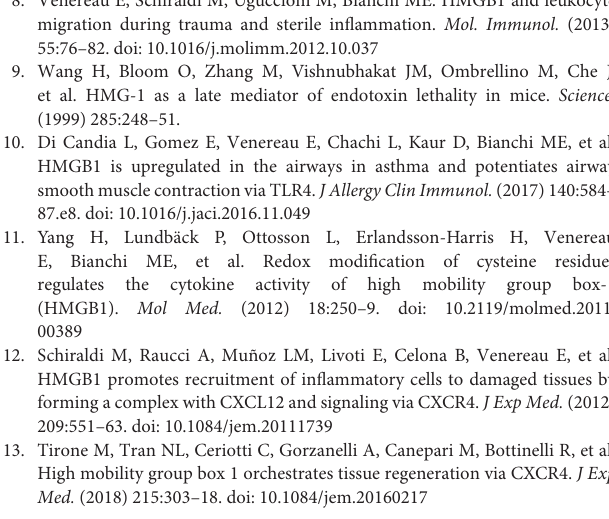
Supplementary Figure 1 | HMGB1 redox isoforms expression in muscle and HMGB1 level in serum upon acute muscle injury. (A) Percentage of HMGB1 redox isoforms expression, quantified from Western blot assays performed in non-reducing conditions with anti-HMGB1 antibody, on tibialis anterior (TA) and triceps muscle lysates at indicated time points after cardiotoxin (CTX) injection. A.U. = arbitrary unit ( n = 11 muscles, 3 mice/time point). (B) Quantification of HMGB1 protein level (ng/ml) by ELISA in the serum of control (Ctrl) and CTX-treated mice at indicated time points ( n ≥ 3 mice/time points). (C) Percentage of HMGB1 redox isoforms expression, quantified from Western blot assays performed in non-reducing conditions with anti-HMGB1 antibody, on muscle supernatants at indicated time points after CTX injection. A.U. = arbitrary unit ( n = 6 muscle supernatants, 3 mice/time point). Data represent the means ± SEM and statistical significance was calculated by One-way ANOVA (A–C) . ∗ P < 0.05; ∗∗ P < 0.01; ∗∗∗ P < 0.001; ∗∗∗∗ P < 0.0001. Supplementary Figure 2 | Redox modulation of HMGB1 during cancer cachexia. (A) Body weight (g) of mice injected with LLC or C26 cells at day 0 or at the endpoint of the experiment. (B) Weight loss percentage of gastrocnemius (GAS), tibialis anterior (TA), and quadriceps (QUAD) muscles from LLC- or C26-bearing mice ( n ≥ 4 mice/group). (C) Quantification of HMGB1 protein level (ng/ml) by ELISA in the serum of control (Ctrl) or tumor-bearing mice (LLC or C26)